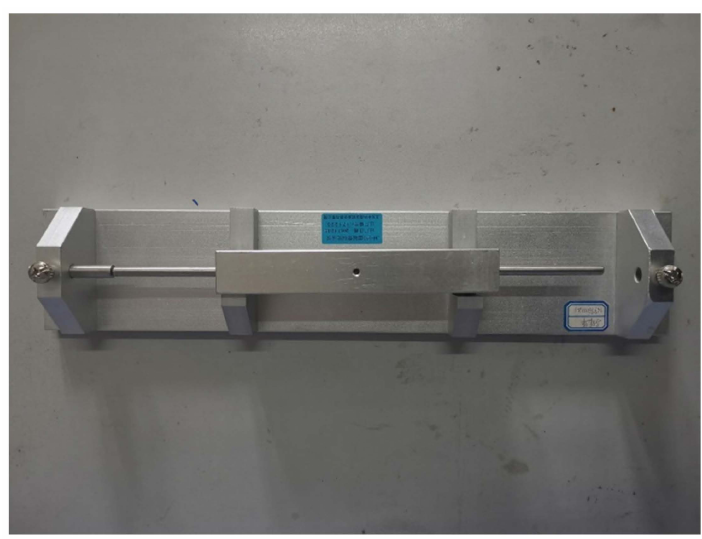
Figure 3. JH-320 alkali aggregate length comparator. For each group, the arithmetical mean value of shrinkage for the three samples was taken as the final dry shrinkage value. If the dry shrinkage value for a sample deviated from the mean value by >15%, the mean value of other samples was taken as the final value. If the dry shrinkage values of two samples deviated from the mean value by >15%, the dry shrinkage test was